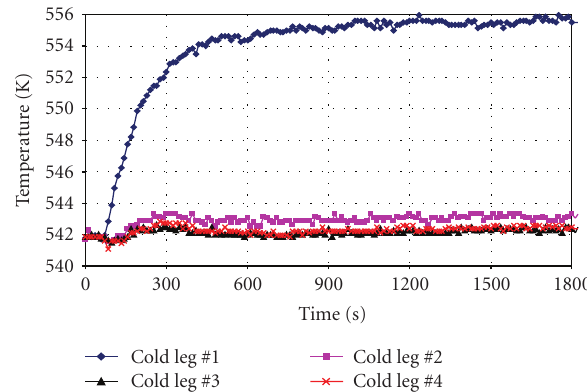
Figure 13: Measured evolution of the hot legs during the test at the KNPP.